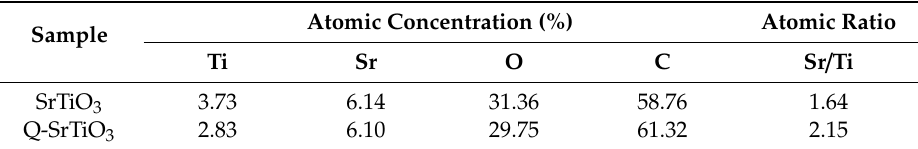
Table 1. Summary of the XPS data for the SrTiO 3 and Q-SrTiO 3 . Atomic Concentration (%) Atomic Ratio Sample